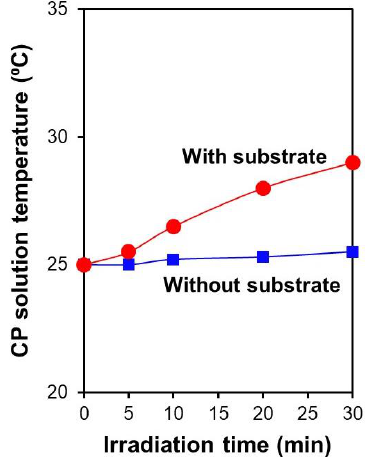
Figure 4. Variation of the temperature of the supersaturated calcium phosphate (CaP) solution (CP solution) with the laser irradiation time for the Co−Cr alloy substrate (without using the temperature-controlled water bath).